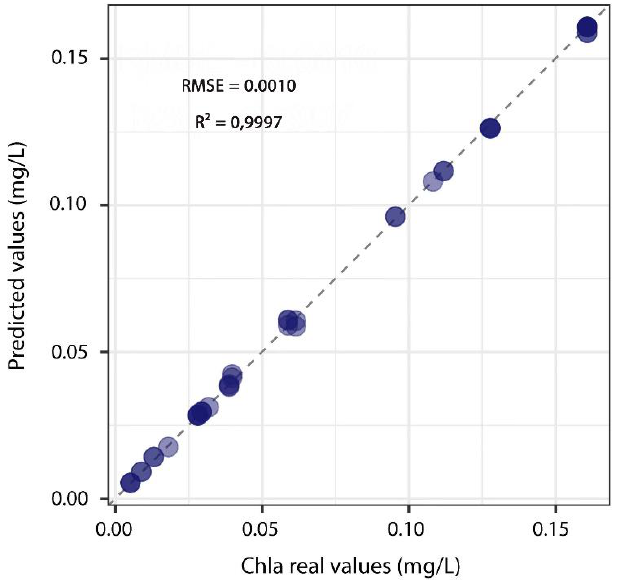
Figure 5. Comparison of the predicted and actual chlorophyll a concentration in the random forest model (the depth of point color represents the number of the value).